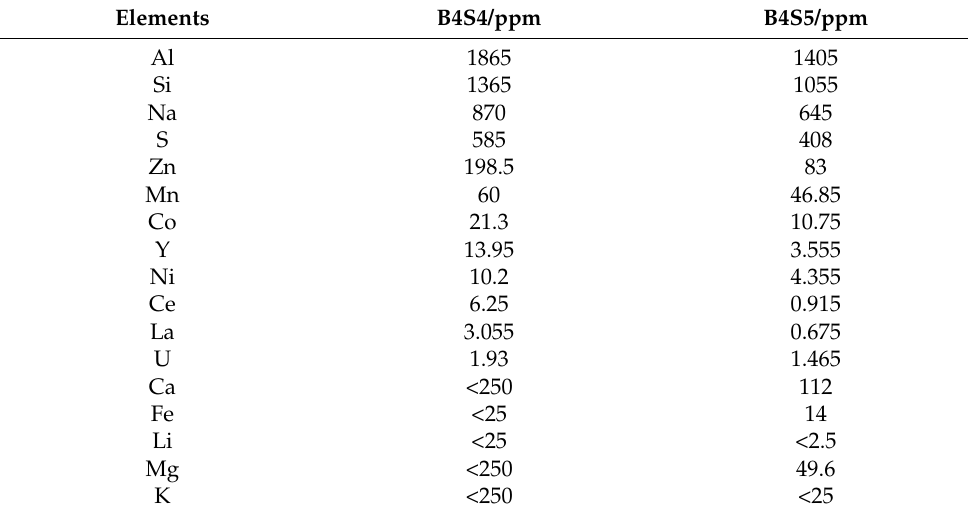
Table 3. Concentrations of the major elements in the solutions before (B4S4) and after (B4S5) oxalic acid